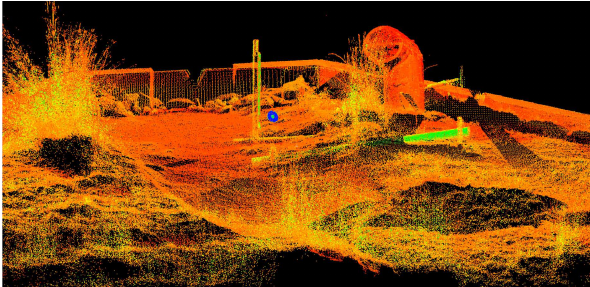
Fig. 2. Point-cloud image of weir area showing V-notch, stick gauge, and stilling well/logger housing. The bright blue point is a reference reflector used for combining scans from different loca- tions and the green angled tube is the housing for a conductivity